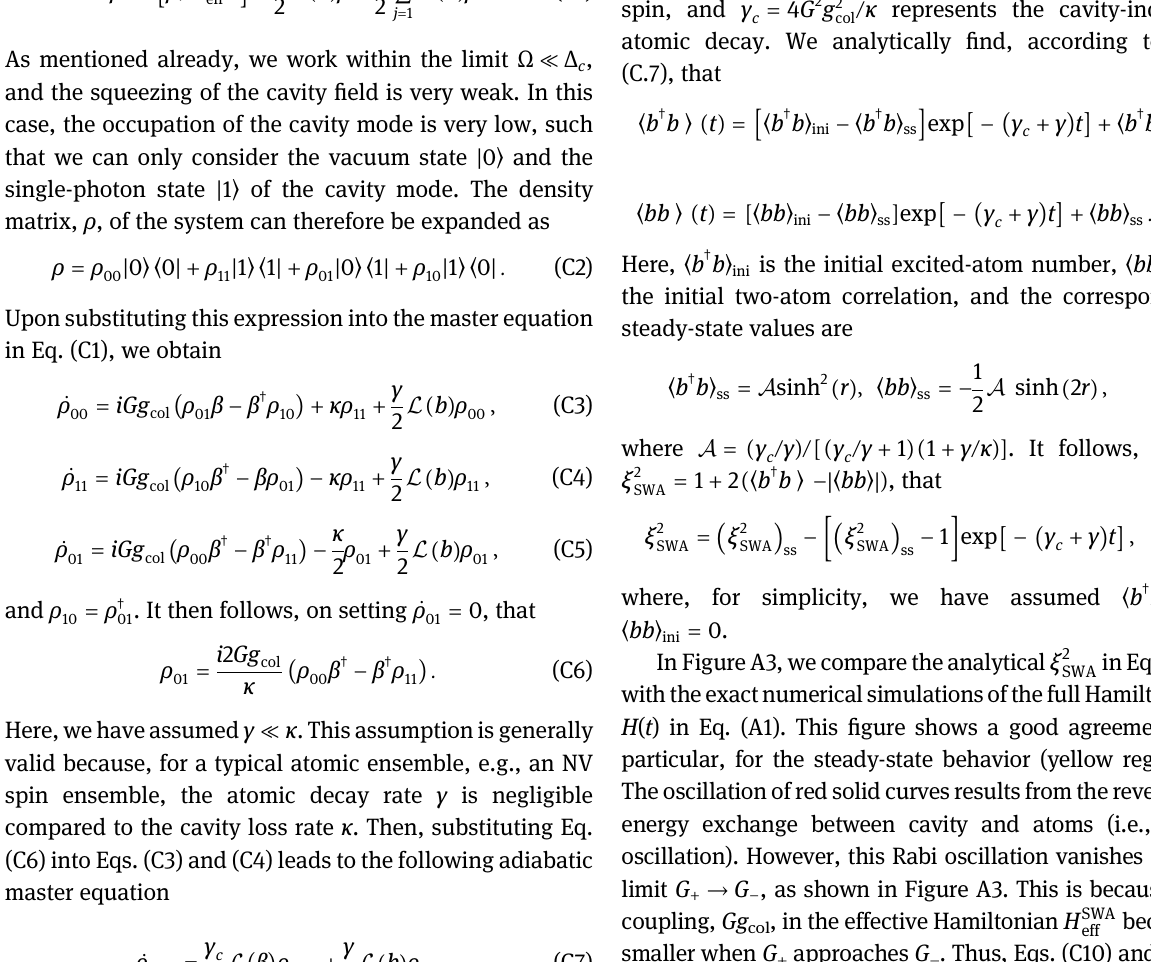
Figure A3: Evolution of the spin squeezing parameter ξ 2 Hamiltonian H ( t ) in Eq. (A1), while dashed curves are analytical predictions given by Eq. (C11). The analytical expression can predict well the squeezingofthecollectivespin,inparticular,forthesteady-statebehavior(yellowregions).Here,wehavemadethespin-waveapproximation for H ( t ). In all plots, we have assumed that Δ c (cid:2) 200 κ , Ω (cid:2) 0 . 1 Δ c , γ (cid:2) 0 . 01 κ , state and the cavity is in the